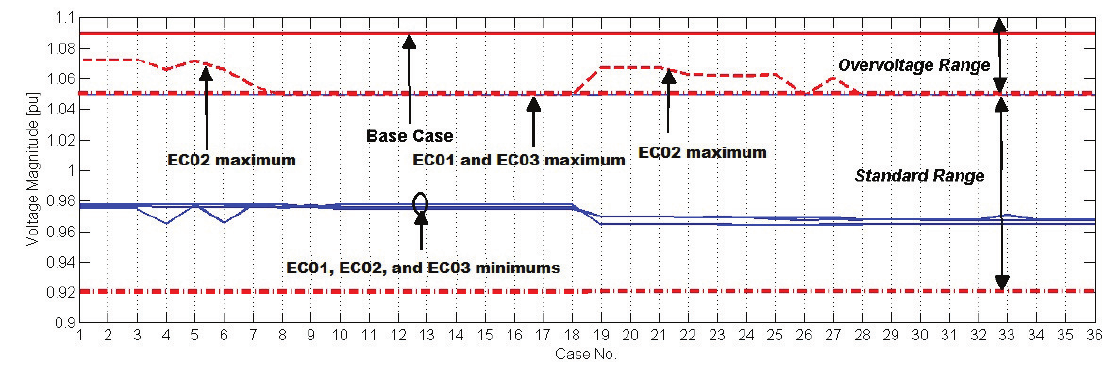
Figure 8. Voltage range in the FirstEnergy transmission